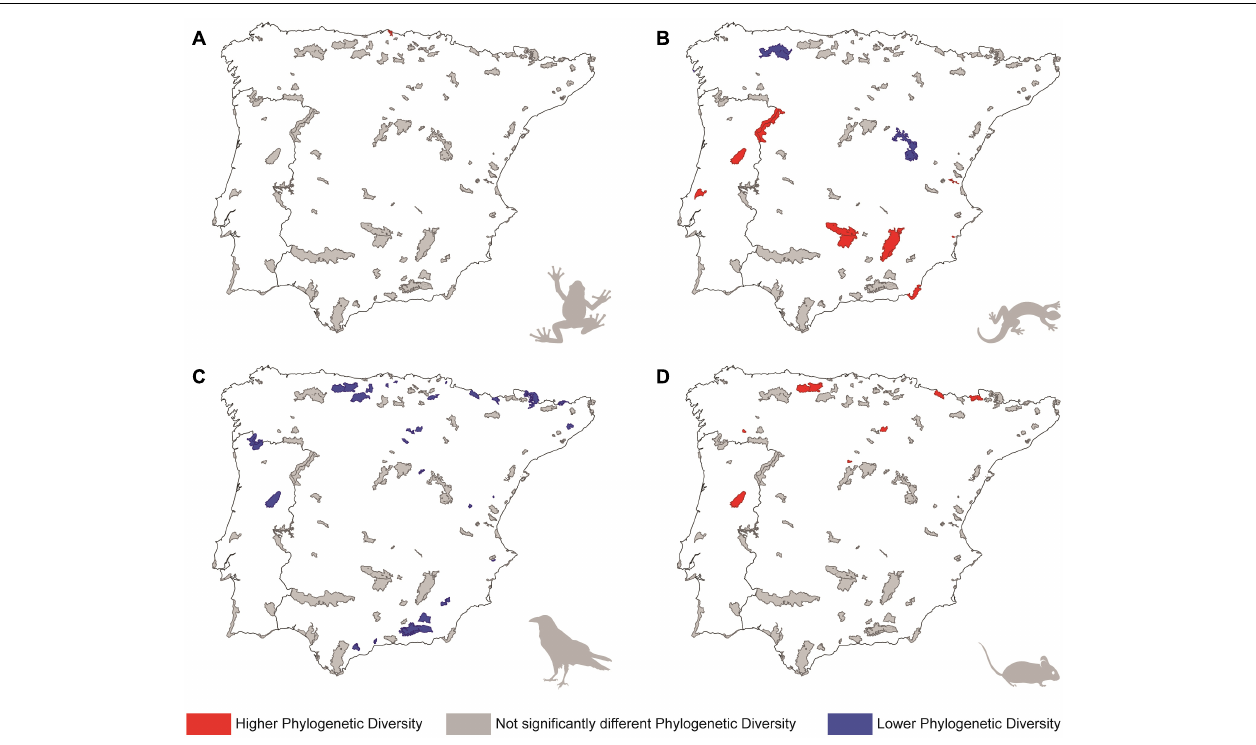
FIGURE 2 | Representation of the protected areas according to the level of significance of the standardized effect sizes of phylogenetic diversity for different tetrapod groups: (A) amphibians, (B) reptiles, (C) birds, and (D) mammals. Colours indicate whether each protected area holds significantly higher (red) or lower (blue) phylogenetic diversity than it is expected from the region where it stands (an area designed placing its limits 50 km beyond the boundaries of the PA, including also the PA); parks in grey correspond to those where phylogenetic diversity does not differ from a random draw of species from the region where they stands (see main text for more